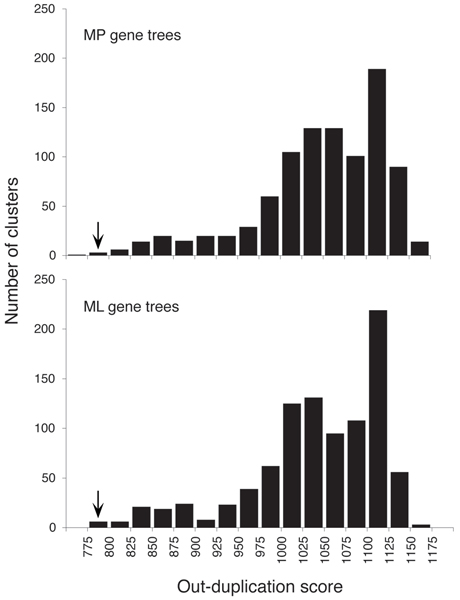
Distribution of duplication scores across all species trees. Distributions of out-duplication scores across all 945 binary angiosperm species trees (all rooted with Pinus). An out-duplication score is the sum of all out-duplications required to reconcile all 577 gene trees (or sets of trees) to that species tree. The upper panel shows the distribution of scores when the gene trees were estimated using maximum parsimony; the lower panel gives the same for the maximum likelihood gene trees. Arrows indicate the bins in which the accepted species tree occurs. For the MP gene trees, the accepted species tree was fourth from the best and had a score of 796.3 (the optimal species tree had a score of 771.9). For the ML gene trees, the optimal tree was the same as the accepted tree and had a score of 779.0.